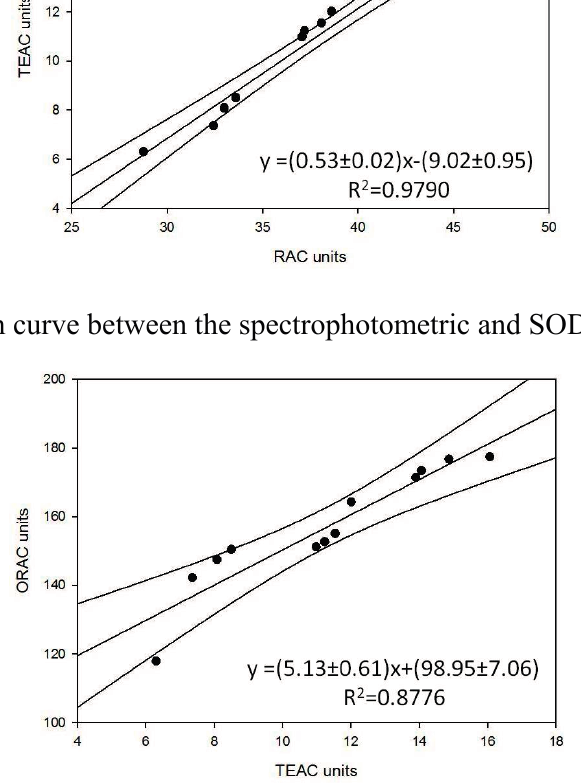
Figure 7. Correlation curve between the ORAC and spectrophotometric